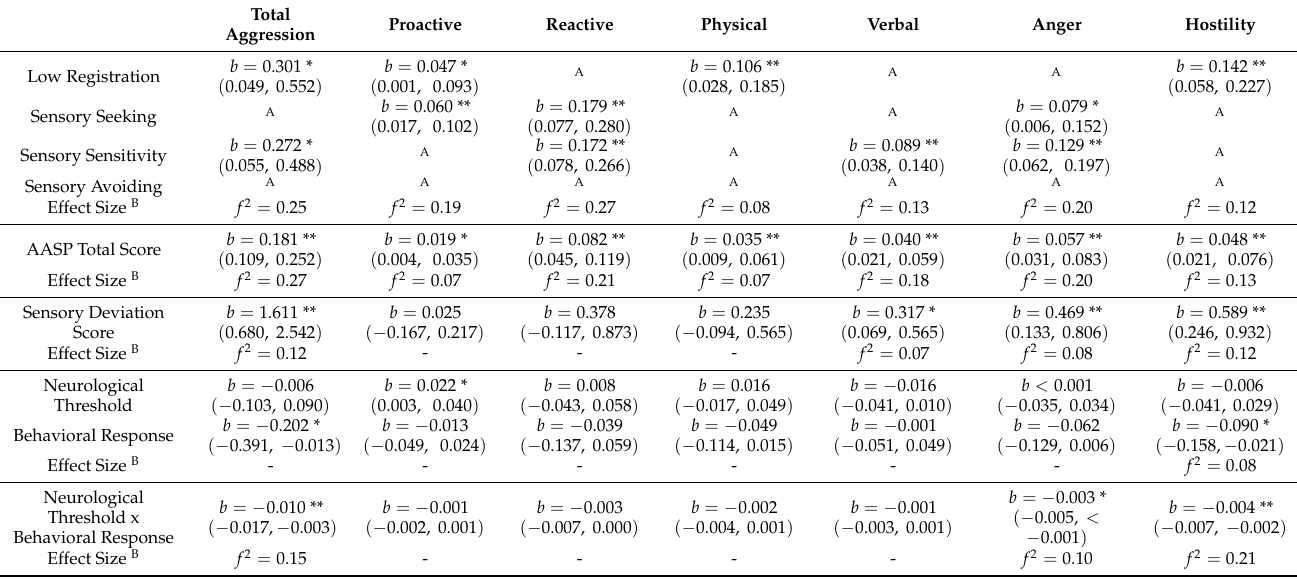
Table 4. Multiple regression models with AASP raw quadrant, total, sensory deviation, neurological threshold and behavioral response scores and specific types of aggressive